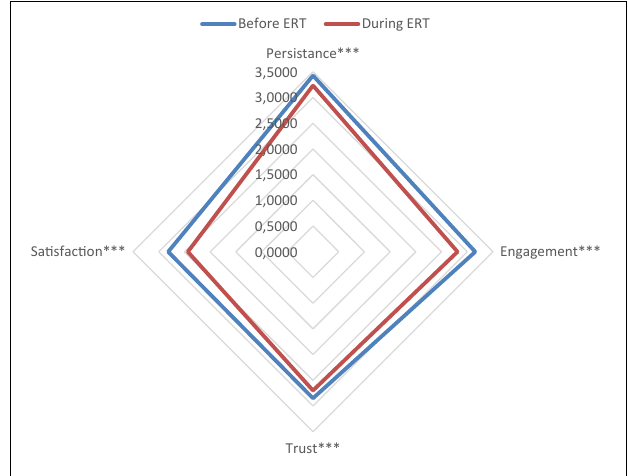
FIGURE 1 | Mean of the values of student achievement between 0 and 1. Source: Learning alone ( N = 677). Paired t-tests ∗ ≤ 0.05, ∗∗ ≤ 0.01, ∗∗∗ ≤